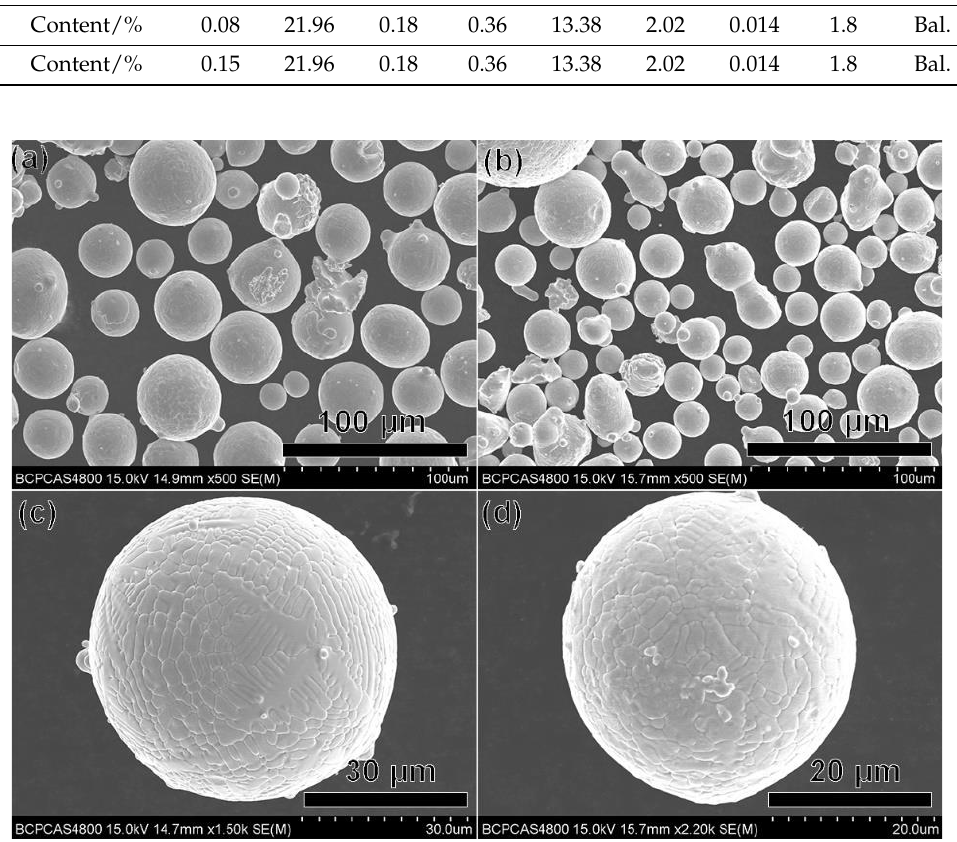
Figure 1. SEM morphologies of the VIGAed powders: ( a ) Haynes 230, ( b ) CRHA, ( c ) Haynes 230, ( d ) CRHA.